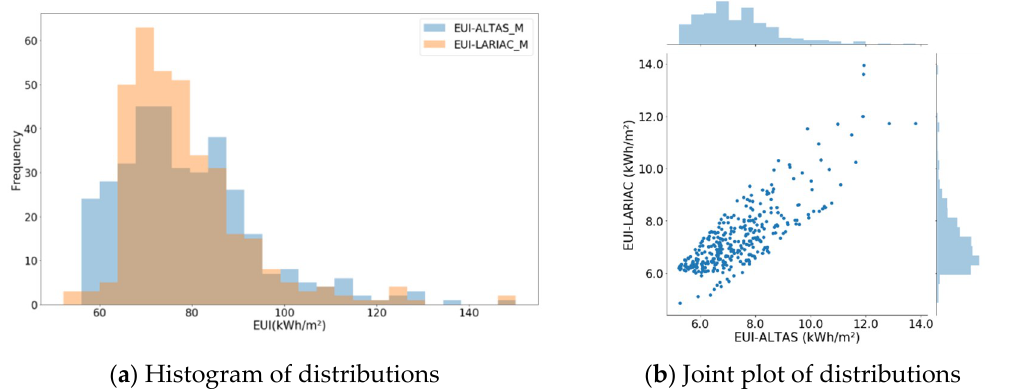
Figure 6. Distributions of the measured and simulated census tracts average EUI (kWh/m 2 ). ( a ): Histogram of distributions, ( b ): Joint plot of distributions.